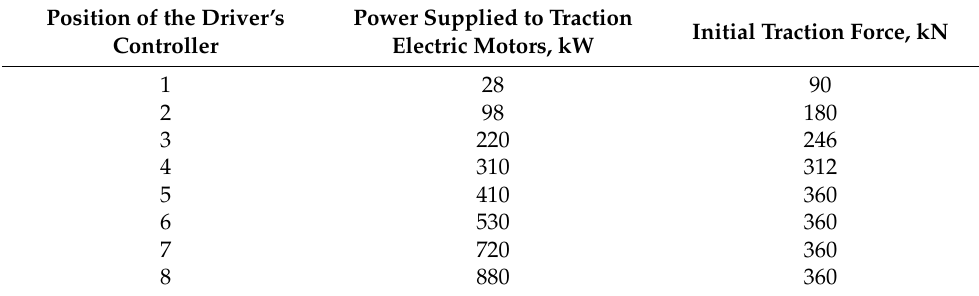
Table 3. Power and start tractive